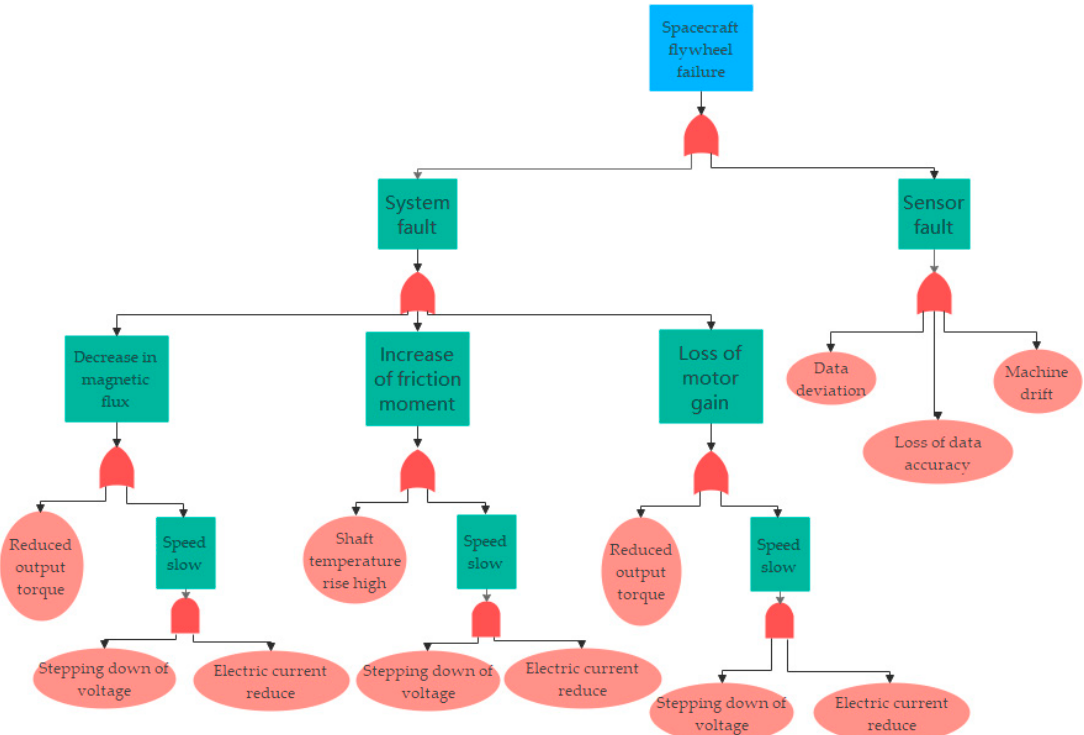
Figure 3. Graph of flywheel system fault tree.